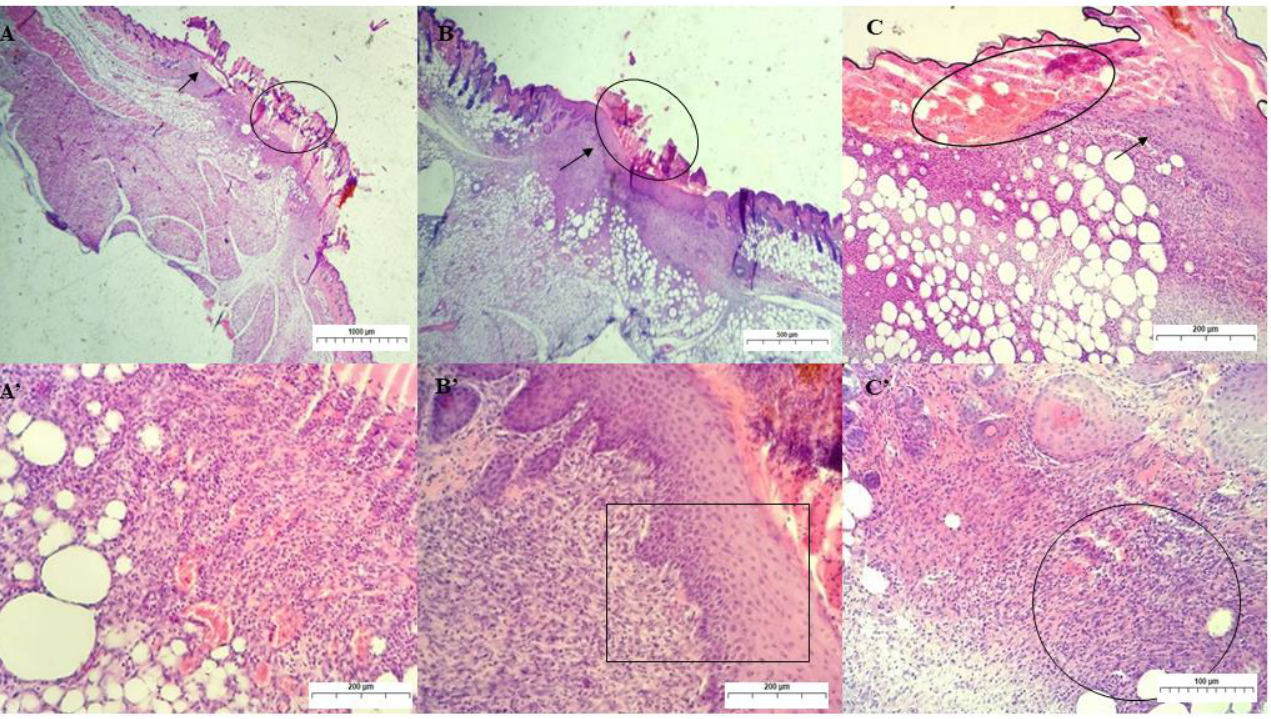
Figure 10. Photomicrograph of skin lesion in mice on the 7th day of treatment. ( A ): Granulation tissue (arrow) and crust (circle) in the wound treated with PS, showing in detail ( A ’ ) area of vascularized granulation tissue and intense MN inflammatory infiltrate (magnification: 20× and 100×, respectively). ( B ): Cutaneous wound treated with GChi showing the presence of acanthosis (arrow) and crust (circle), and in detail ( B ’ ), acanthosis (magnification: 40× and 100×, respectively). ( C ): Skin wound treated with GChiN2, where acanthosis is observed at the right edge of the border (arrow) and, in detail ( C ’ ), immature granulation tissue (magnification: 100× and 200×, respectively). Staining by H.E. physiological serum (PS), chicha hydrogel (GChi), chicha hydrogel with 0.02 g mL −1 nerolidol (GChiN2), polymorphonuclear leukocytes (PMN).